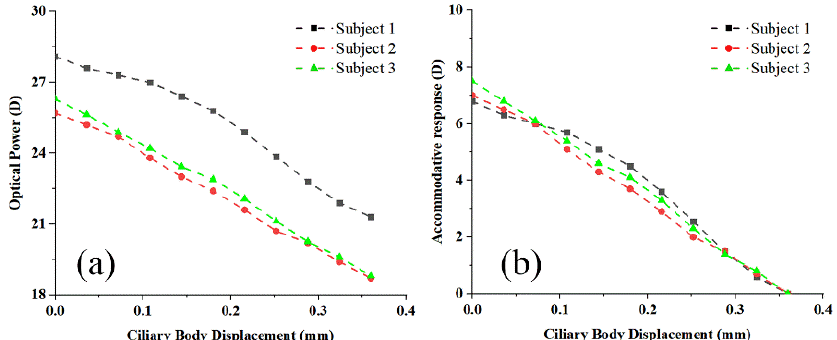
Figure 6. Variations of refractive power ( a ) and accommodative response ( b ) with ciliary body pulling in 3 subjects.